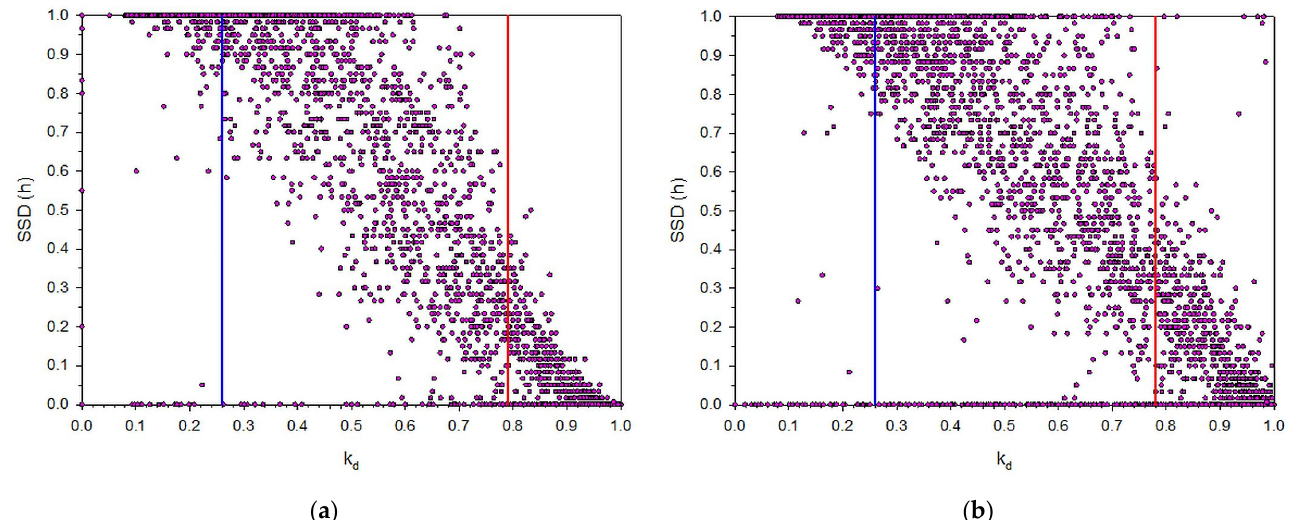
Figure 16. Determination of clear, intermediate, and overcast skies for the ( a ) PAY and ( b ) REG sites.